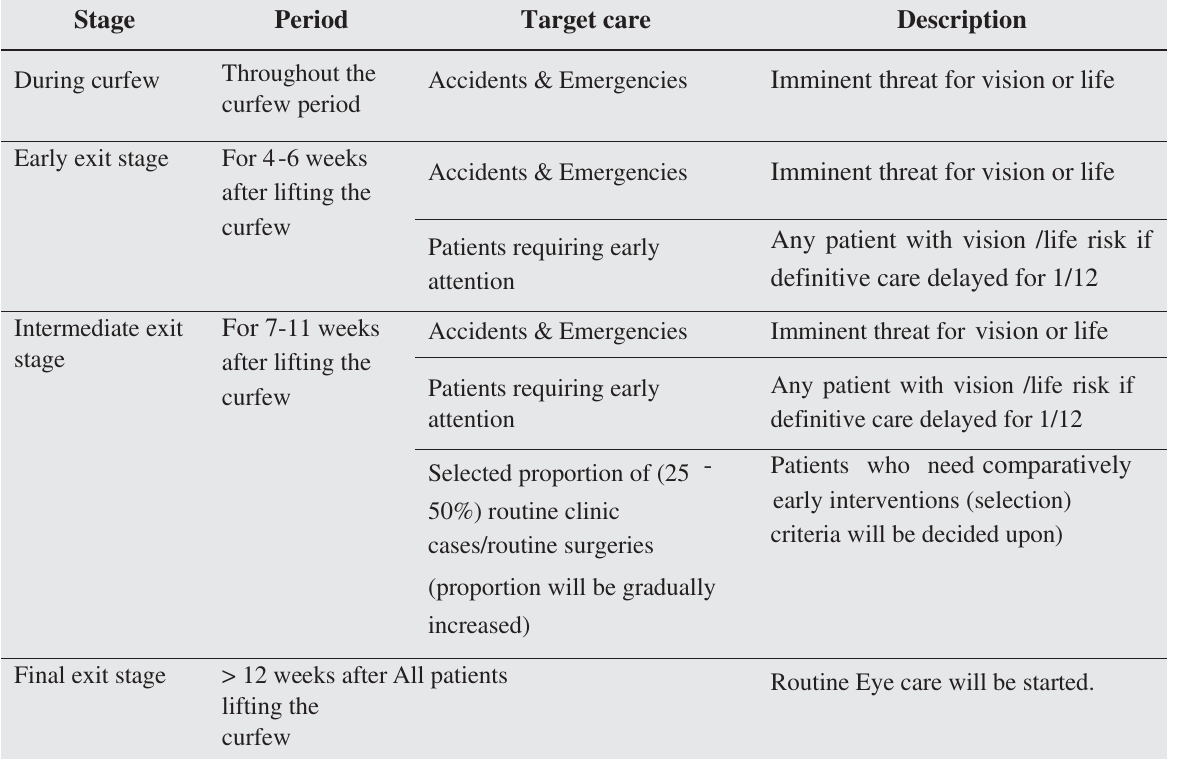
Table 1: Exit plan for NEHC after lifting the